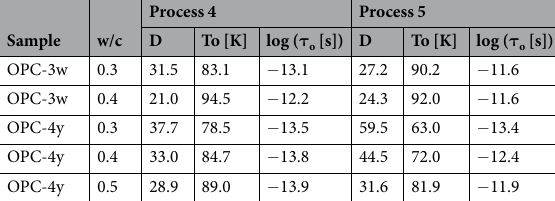
Table 3. VFT parameters for processes 4 and 5 showed in Fig. 4.